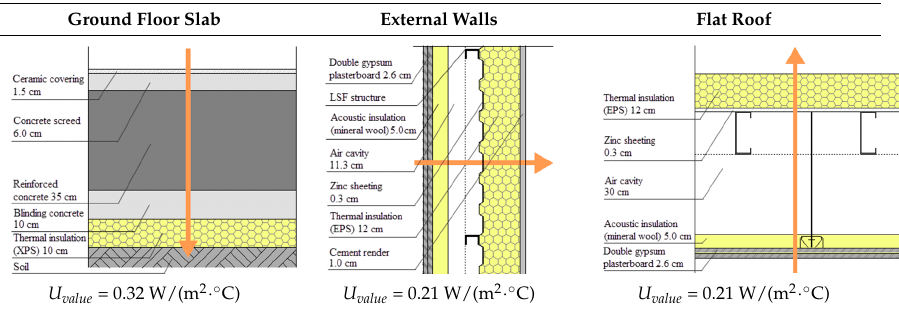
Table 1. Constructive solutions of the opaque building envelope.